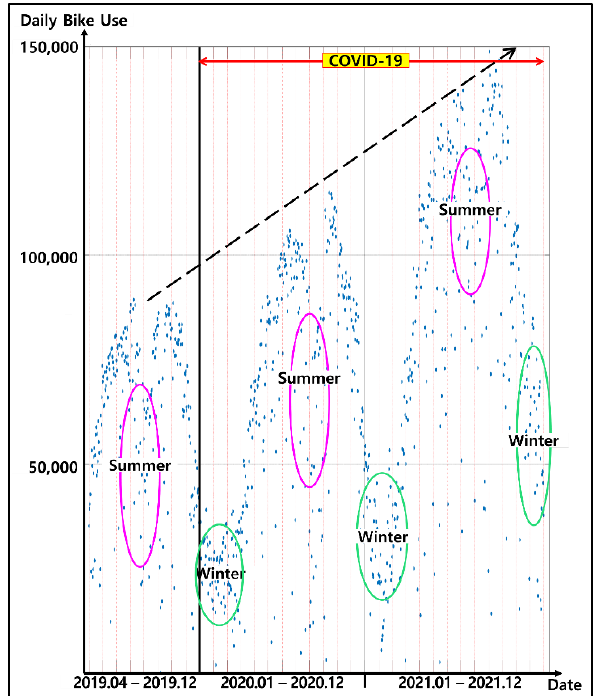
Figure 2 . Daily Bike Use in Seoul (2019.04 – 2020.12)